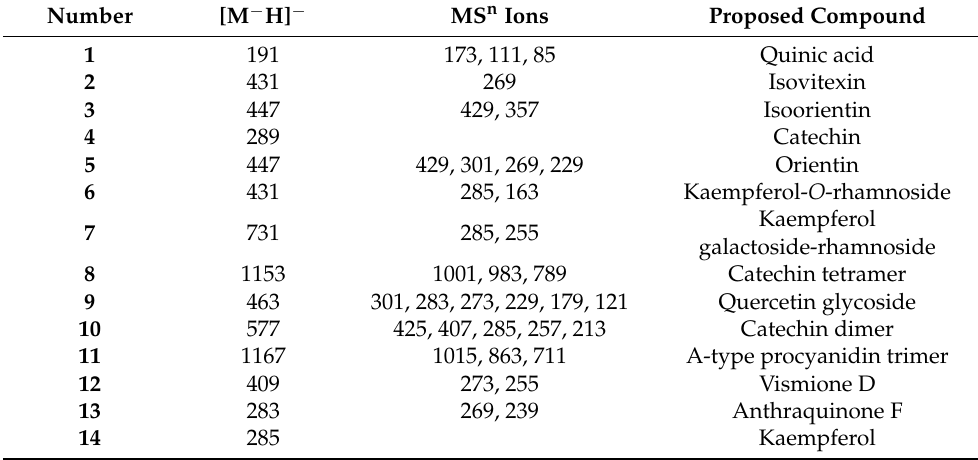
Table 2. Compounds identified by MS n in Vismia guianensis extract.